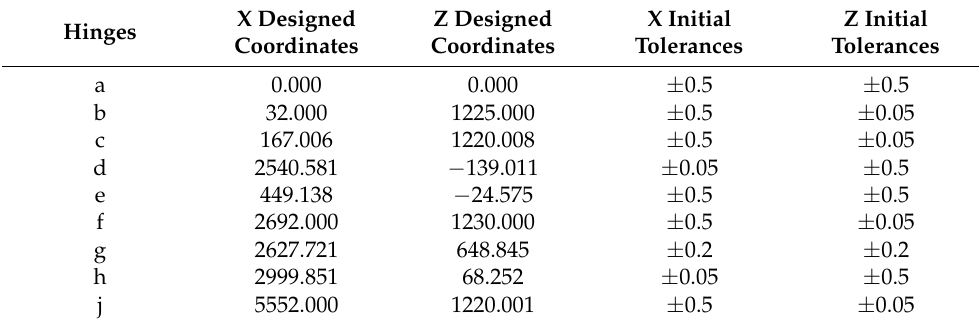
Figure 13. The LSDM’s model and the actual assembly scene. Table 2. The designed coordinates and initial tolerances of the hinges in X-O-Z plane.